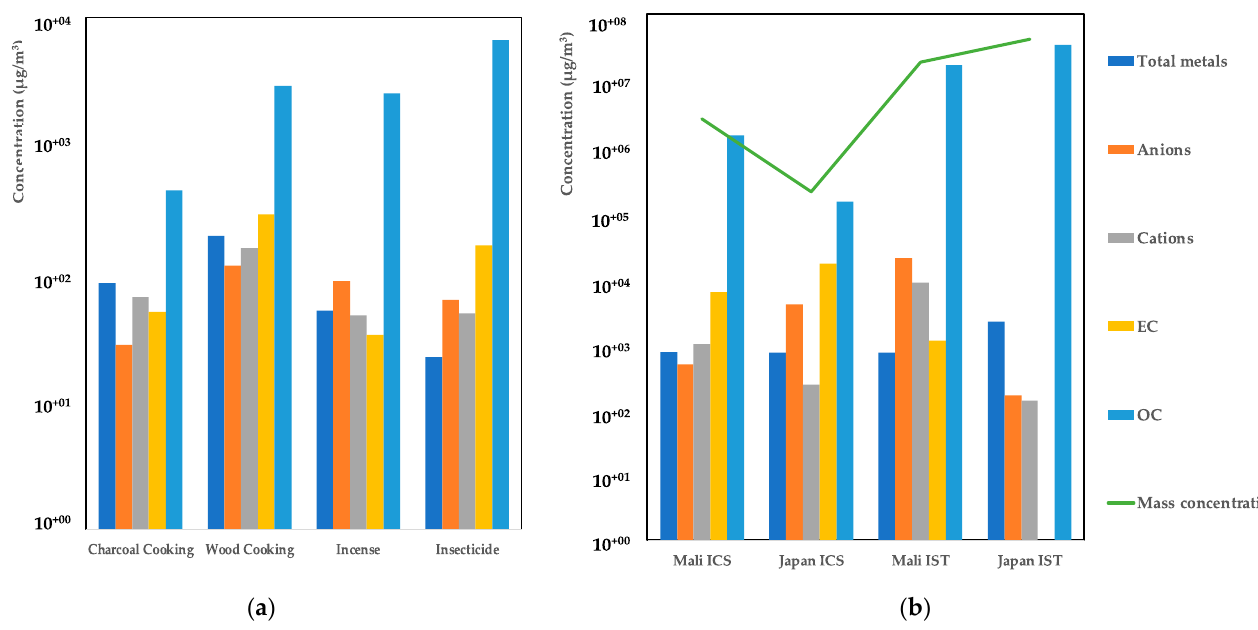
Figure 2. Average concentration of particulate matter constituents. ( a ) in situ samples (N = 18); ( b ) laboratory samples (N = 22). ICS: incense; IST: insecticide.